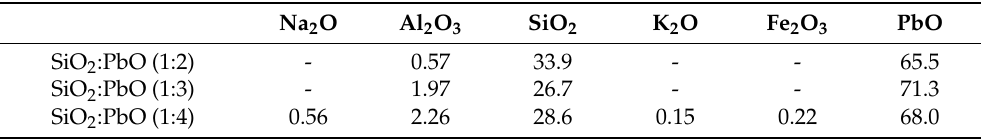
Table 2. Base glasses composition (wt.%) obtained by XRF.